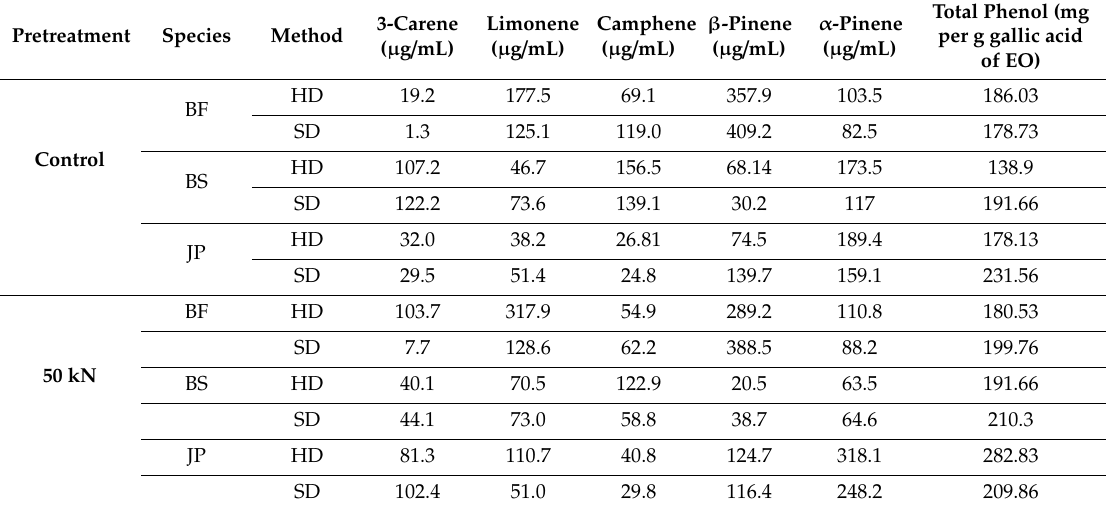
Table 3. The chemical composition of EOs extracted by hydrodistillation (HD) and steam distillation (SD) from residual forest biomass densified into bundles (50 kN) and the control for BF, BS, and JP. Pretreatment Species Method